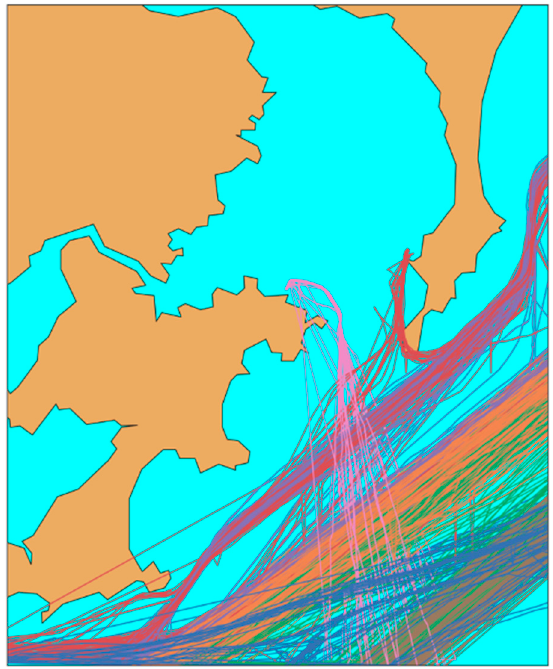
ff erent densest